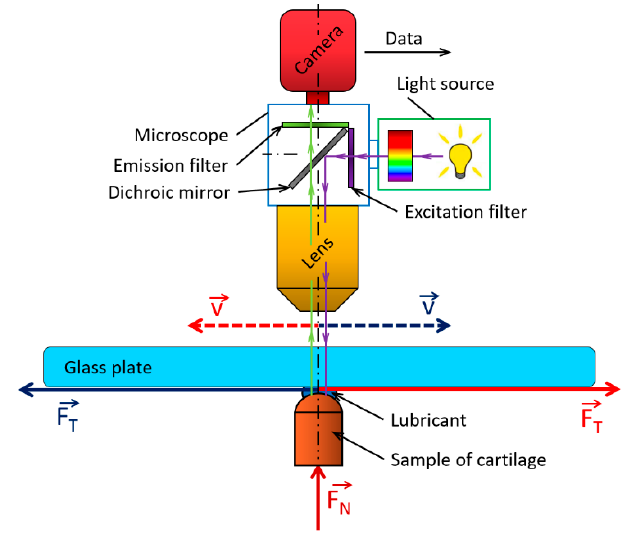
Figure 1. Schema of the experimental apparatus.